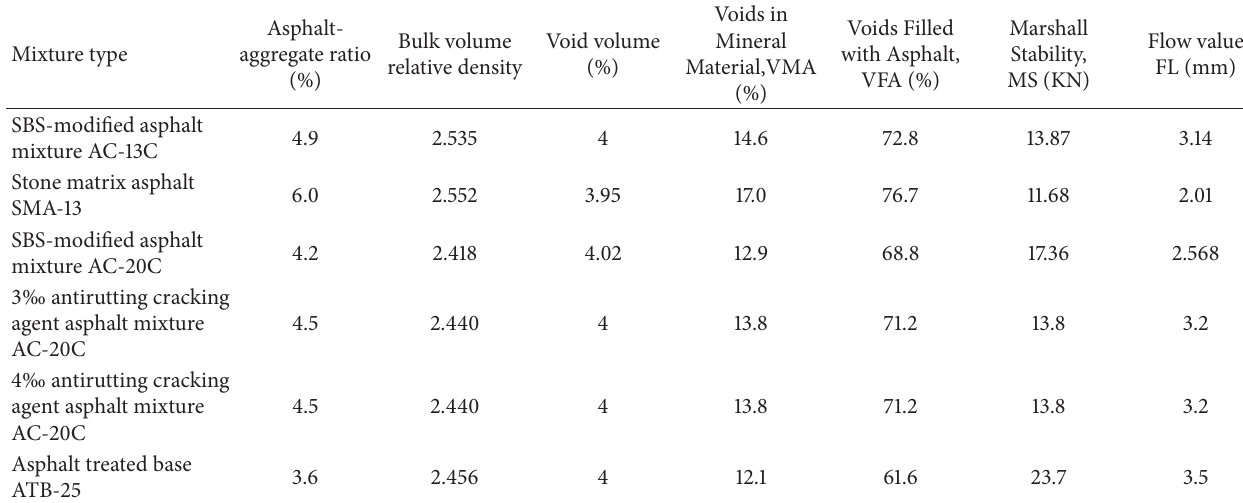
Table 2: Material properties of different mixture.